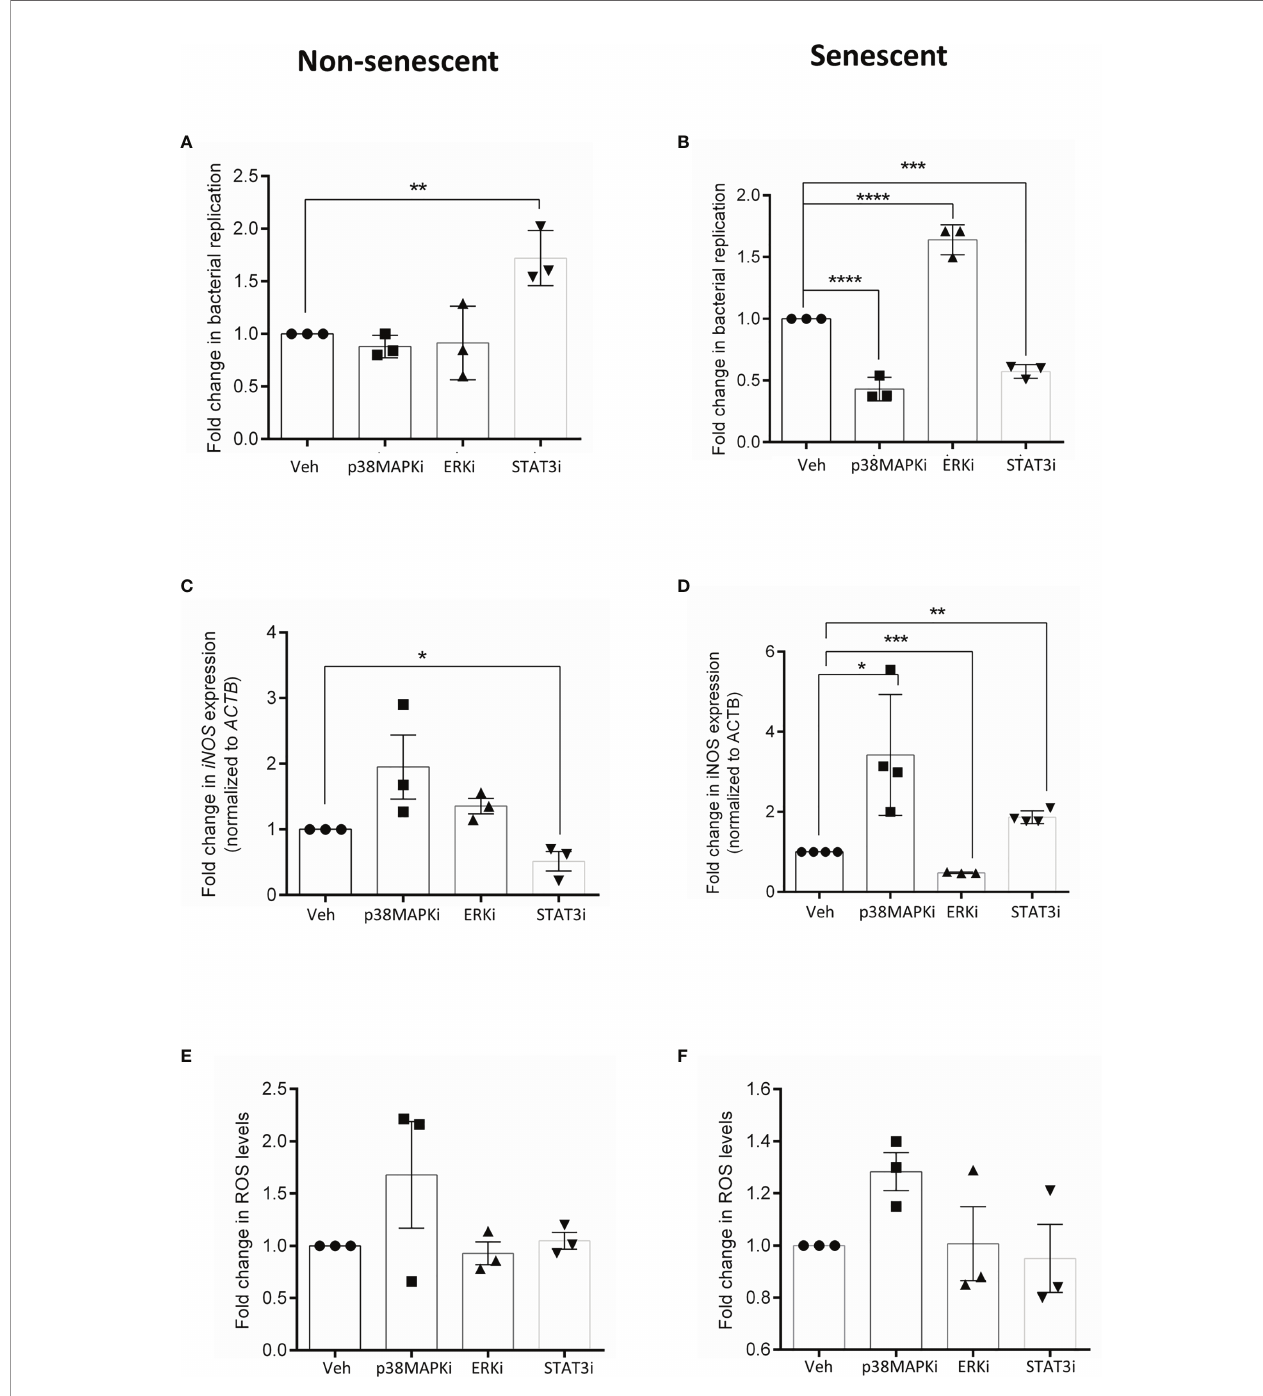
FIGURE 2 | Effect of inhibiting p38 MAPK, ERK and STAT3 kinases on infection in non-senescent (left) and senescent (right) cells and correlates with its effect on cellular iNOS. (A, B) Fold change in bacterial replication (relative to vehicle control) at 16h in non-senescent and senescent HeLa cells, respectively after treatment with p38 inhibitor, SB 202190 (p38MAPKi), MEK inhibitor PD184161 (ERKi) and JAK/STAT inhibitor AG490 (STAT3i). (C, D) iNOS gene expression analysis by qRTPCR in non-senescent and senescent HeLa cells, respectively. Values were normalized to b-actin and then wrt vehicle-treated cells to determine fold changes. (E, F) Determination of ROS levels by DCFDA in non-senescent and senescent HeLa cells, respectively. Fold changes obtained after normalization to levels in vehicle-treated cells. The data represents mean ± SEM from atleast three independent experiments. Statistical signi fi cance of differences was analysed by Independent t-test, *P ≤ 0.05, **P ≤ 0.01, ***P ≤ 0.001, ****P ≤ 0.0001. Veh, vehicle DMSO treated cells; p38MAPKi, treated with p38 inhibitor, SB202190; ERKi, treated with MEK inhibitor, PD184161 and STAT3i, treated with JAK/STAT inhibitor,